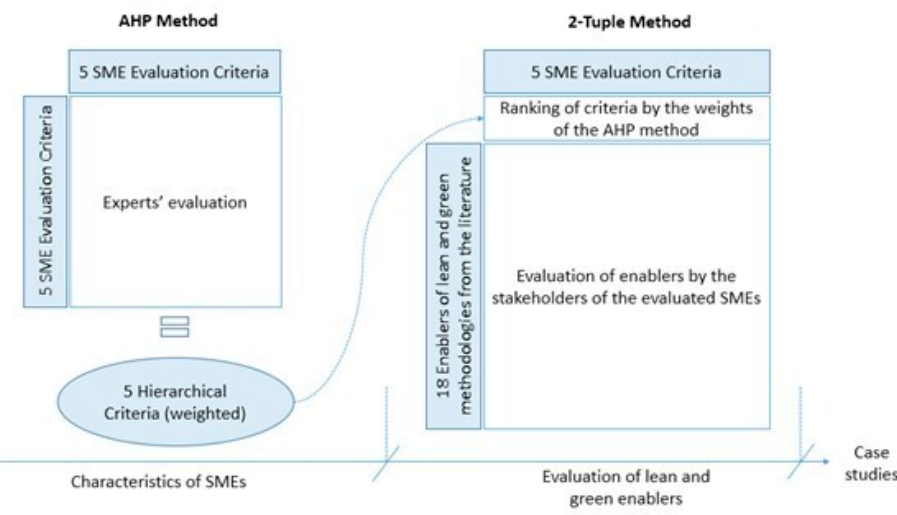
Figure 1. Evaluation model for NPD operations in SMEs.